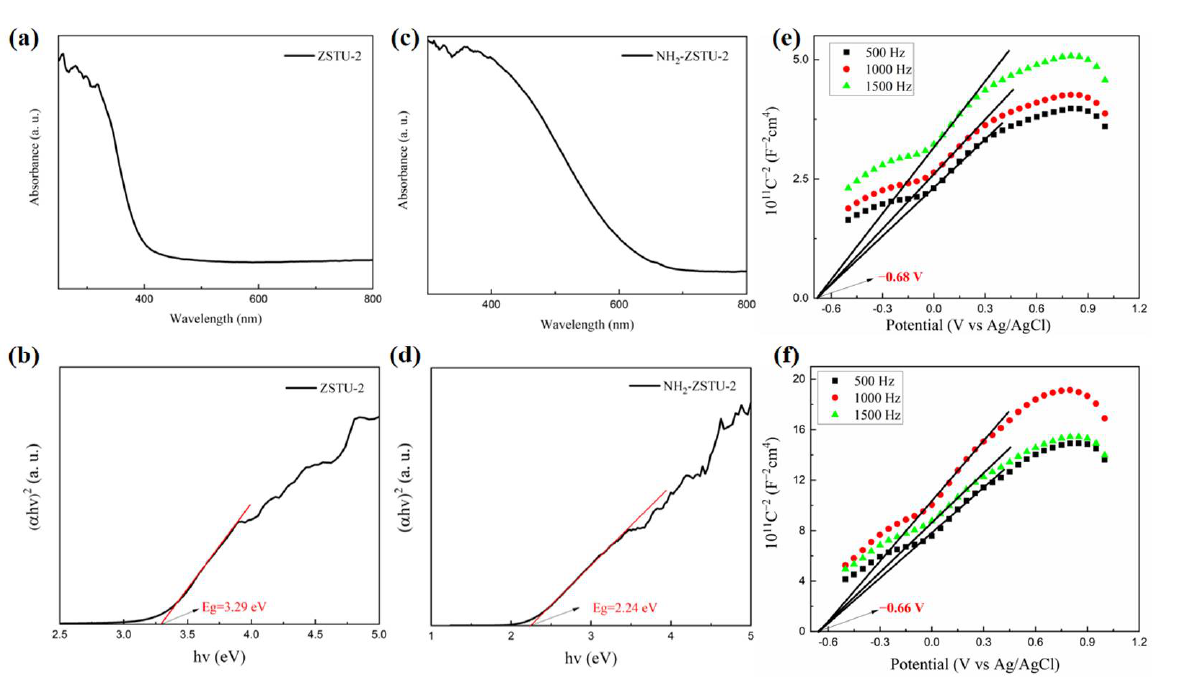
Figure 5. Band structural information of photocatalysts. The solid-state diffuse reflectance absorption spectra of ZSTU-2 ( a ) and NH 2 -ZSTU-2 ( c ); Tauc plots for ZSTU-2 ( b ) and NH 2 -ZSTU-2 ( d ), presenting band gap of MOFs calculated under the hypothesis that absorption follows: ( α h ν ) 2 = K (h ν − E g ); Mott–Schottky plots of ZSTU-2 ( e ) and NH 2 -ZSTU-2 ( f ).